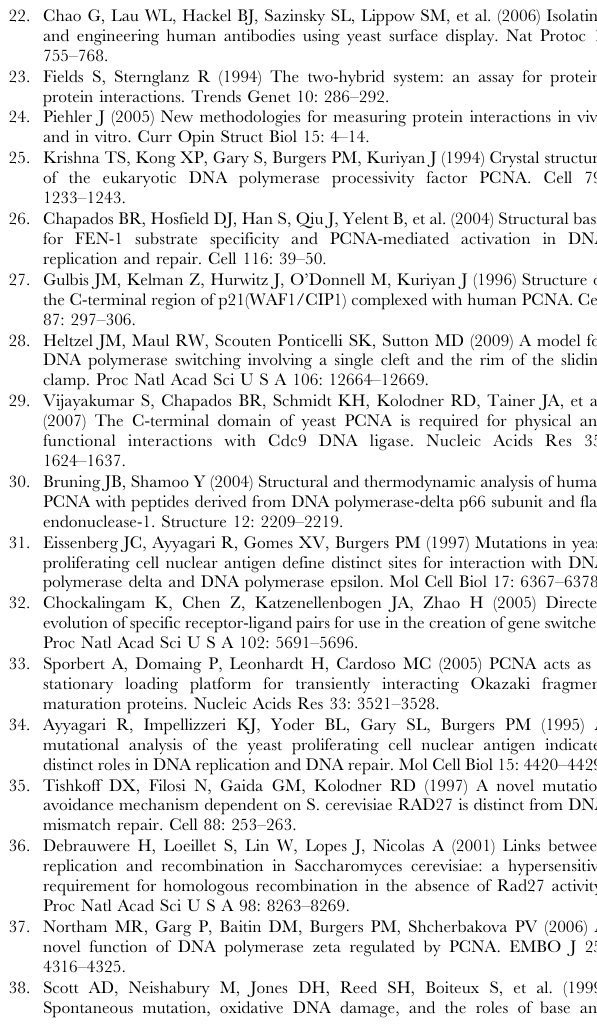
the background of the parent (left) or rad27 -deleted (right) strains. The rad27 deletion results in suppression of the growth sensitivity in the case of the pol30 -Rad30E2 or pol30 - Ung1E2 strains. In contrast, the rad27 deletion had only weak effect on the growth sensitivity of the pol30 -Rad27E6 or pol30 - Msh6E2 mutant strains.